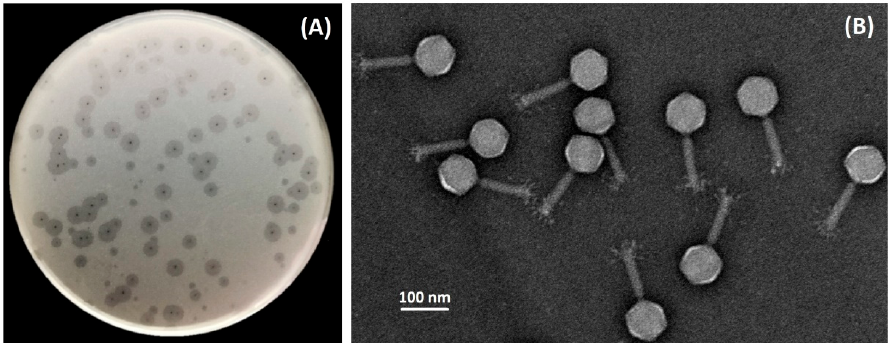
Figure 1. Morphological characteristics of phage TaPaz. ( A ) Phage plaques with opaque haloes on A. baumannii NIPH601. ( B ) Transmission electron micrographs of the phage particles. Staining with 1% uranyl acetate. The scale bar is 100 nm.